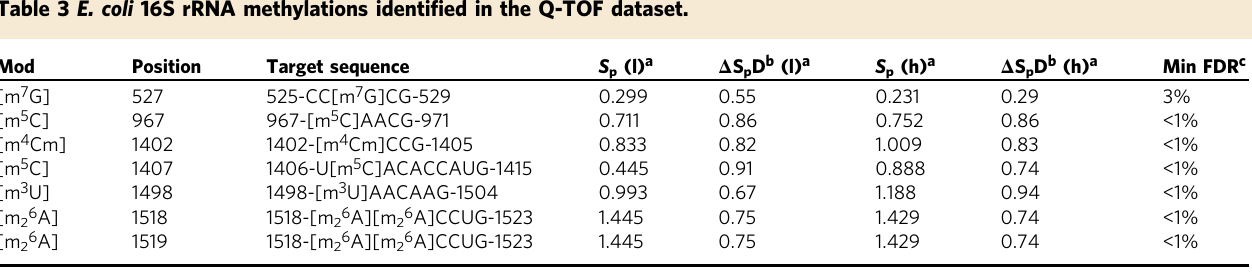
Table 4 RNA modi fi cations identi fi ed in the mixture of S. cerevisiae tRNAs. Modi fi cation ID Common RNA modi fi cations Methyl adenosine